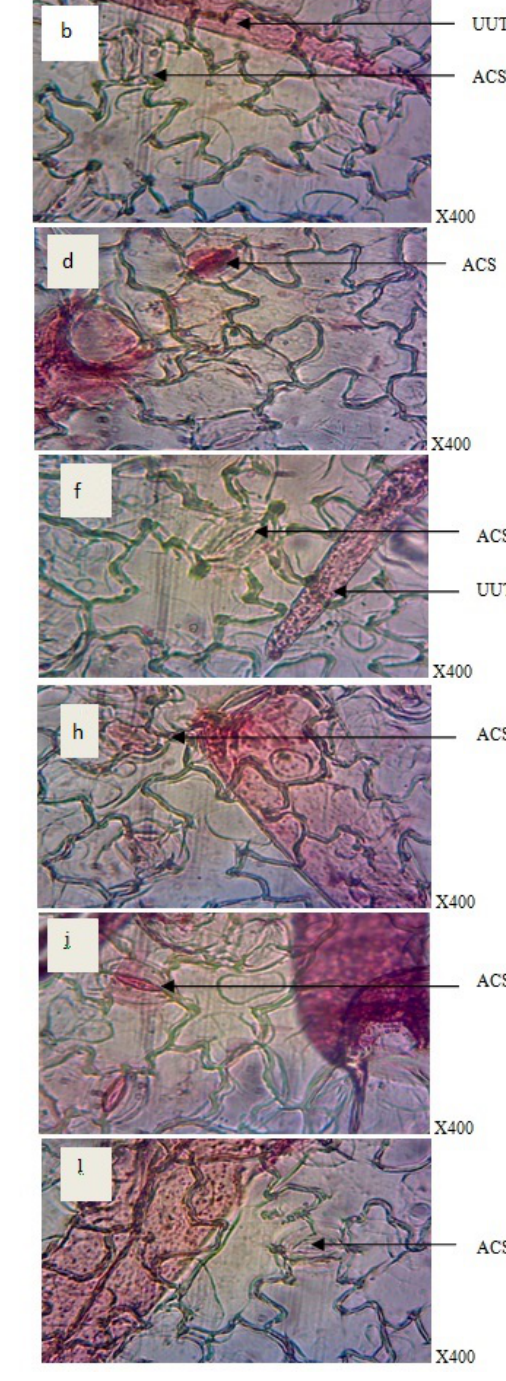
Fig. 1. Leaf epidermal features of S. lycopersicum showing Unicellular uniseriate trichome (UUT) and actinocytic stomata (ACS) in adaxial surfaces of leaf treated with 0%, 5%, 10%, 15%, 20% and 25% concentration of effluent (a,c,e,g,i,k) and abaxial surfaces of leaf treated with 0%, 5% 10%, 15%, 20% and 25% concentration of effluent